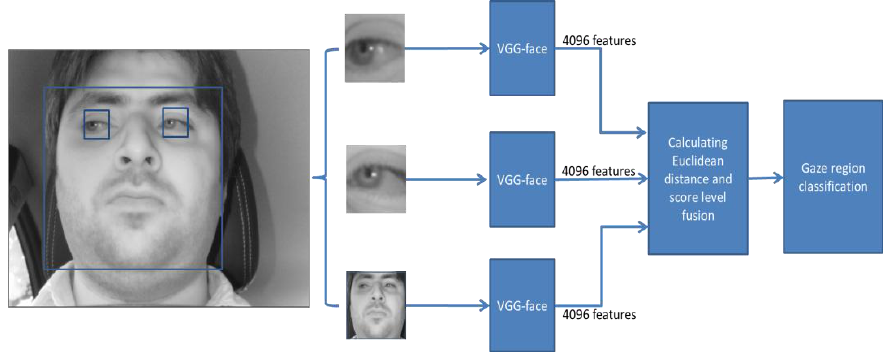
Figure 7. CNN-based driver’s gaze classification procedure without PCCR vector (scheme 1).